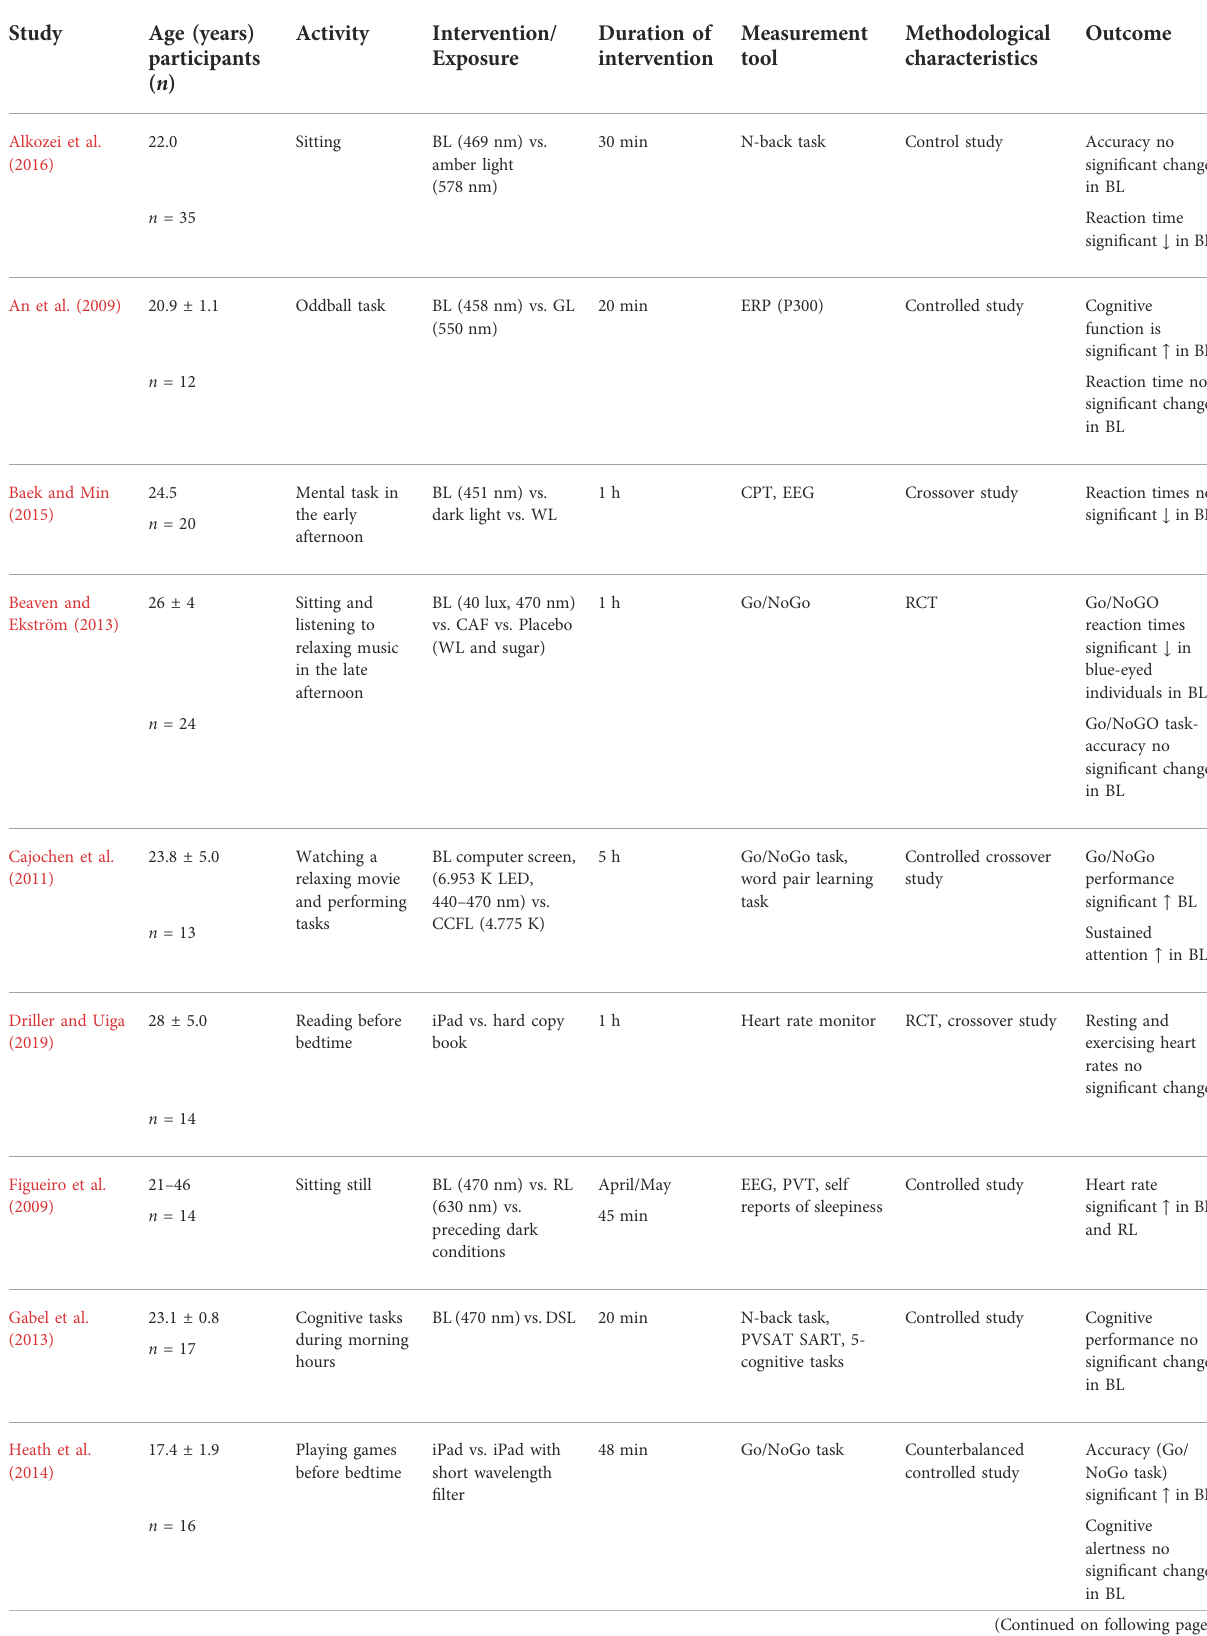
TABLE 4 In fl uence of blue light on